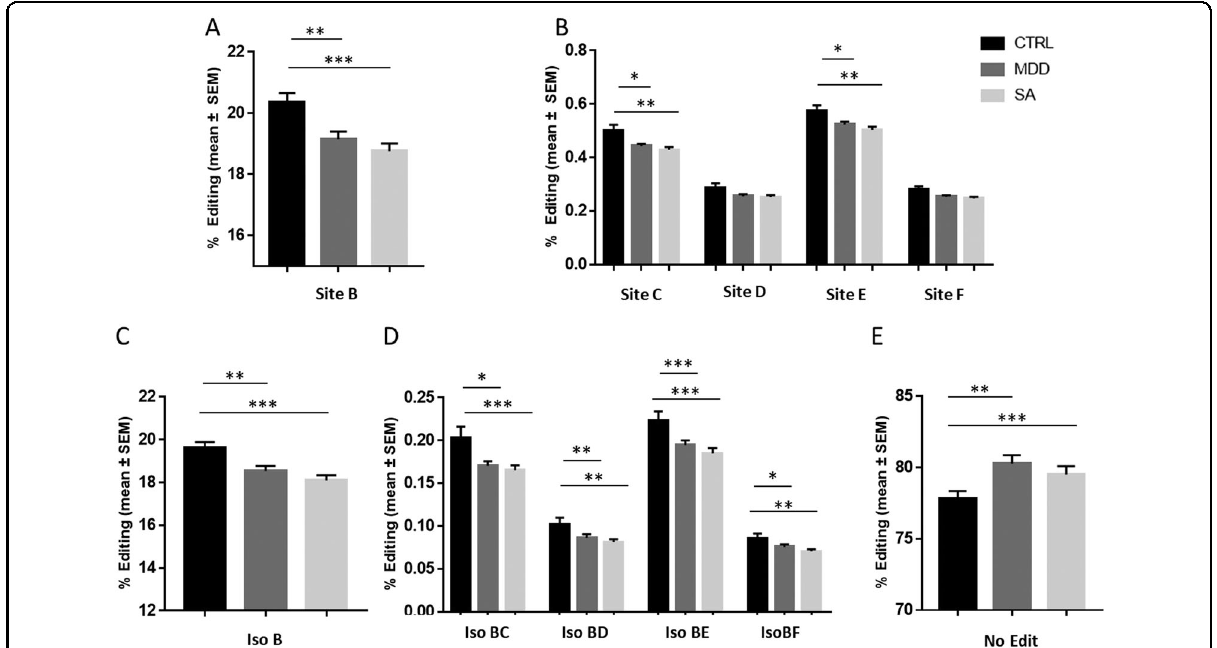
Fig. 3 Relative proportion of mRNA PDE8A editing sites and isoforms measured in controls, depressed patients and suicide attempters. Histograms represent relative editing proportion (%) of the detected PDE8A editing site ( A , B ) or isoform ( C – E ) in healthy controls (mean± s.e.m.; n = 99), DEP group ( n = 82), or SA ( n = 76). Only isoforms representing more than 0.1% of relative proportion were included in the analysis. Black: Controls, Dark grey: DEP; Light grey: SA. The symbol asterisk * p -value ≤ 0.05, ** p -value ≤ 0.01, *** p -value ≤